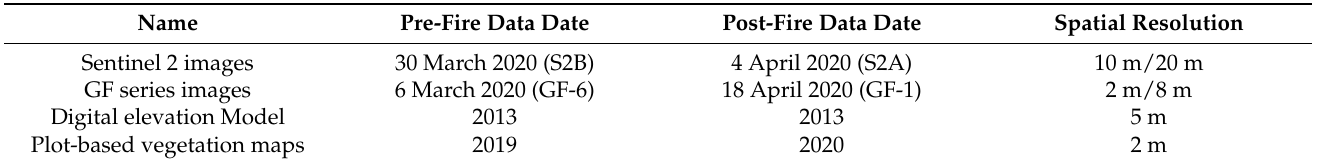
Table 1. List of data used in this study.